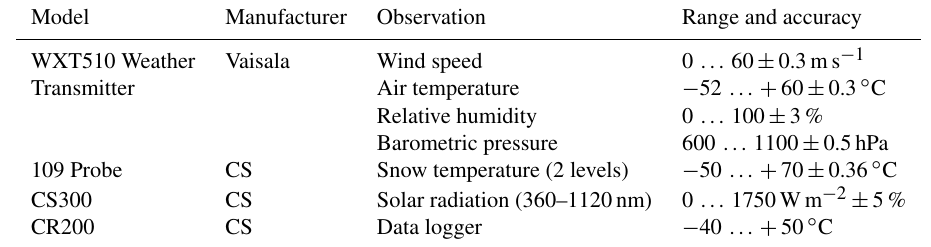
Table 1. Instruments and specifications used on the portable weather station deployed during the field surveys at the northern study